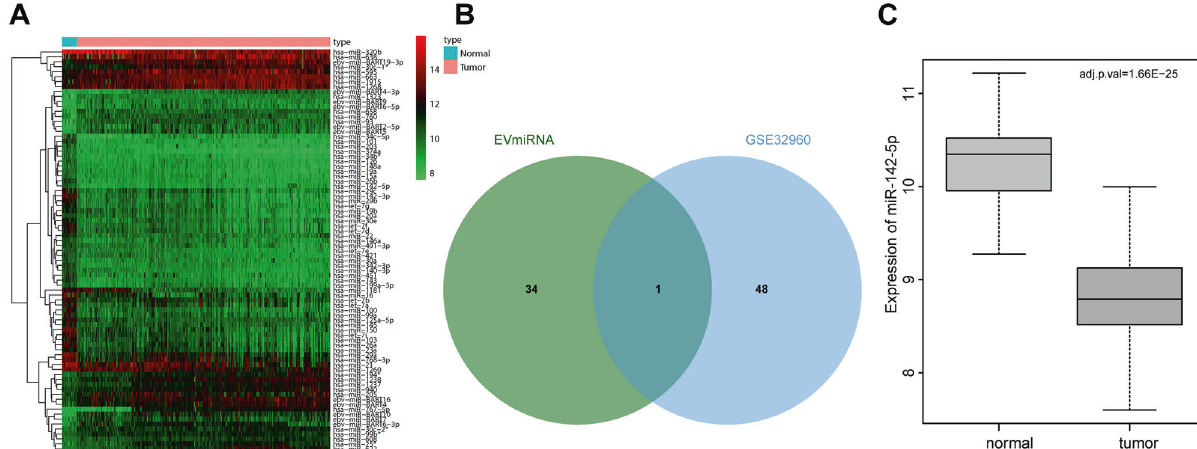
Fig. 1 miR-142-5p is differentially expressed in EVs and poorly expressed in NPC. A Heat map of NPC-related miRNA microarray data (The ordinate showed the name of miRNAs, the tree on the left showed the expression clustering, and the histogram on the upper right showed the color scale). B The remarkably downregulated miRNA intersected with the highly expressed miRNA in peripheral blood EVs from the EVs- miRNA database. C Differential expression of miR-142-5p in expression dataset GSE32960 (The abscissa represented the sample type, the ordinate represented the expression value, and the upper right was the corrected difference p-